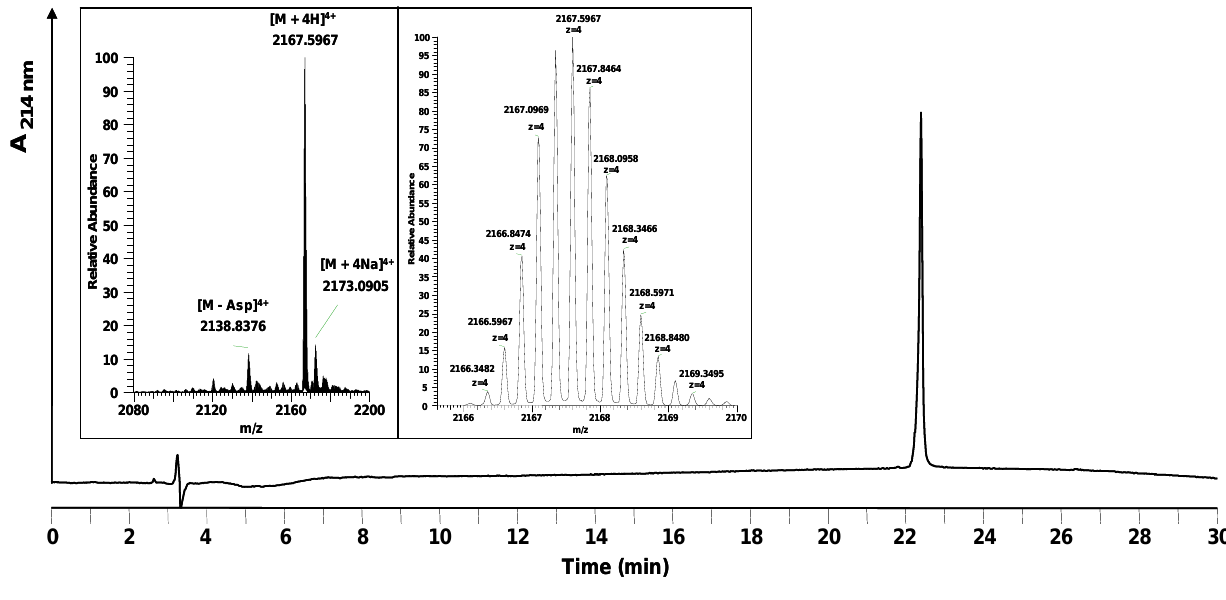
Figure 5. Analytical HPLC and mass spectrometric analysis of the purified entry inhibitor Myr-HBVpreS/2-78. The HPLC chromatogram shows one single peak corresponding to the purified peptide. Insert: mass spectrum obtained (22.37–23.05 min). The signals obtained show the 4-fold charged m/z signals belonging to the desired peptide. The exact monoisotopic mass was calculated to be [M+4H] 4+ = 2166.3504 (measured: [M+4H] 4+ = 2166.3487). Besides the product, one side product was identified to be a peptide missing an aspartic acid in the peptide sequence ([M+4H] 4+ = 2137.5931). Conditions: Hypersil Gold C column; linear gradient of 0.1% TFA in water to 0.1% TFA in acetonitrile in 30 18 minutes, flow rate of 0.2 mL/min, 60 °C, wavelength of 214